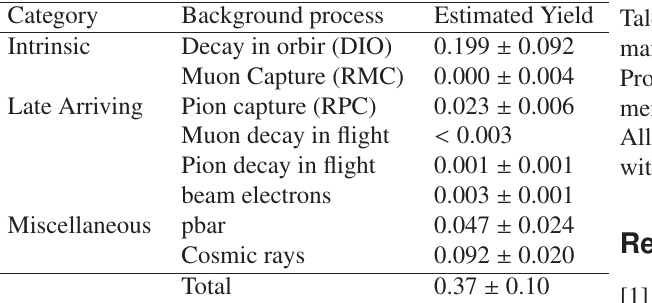
Table 1. Expected background list as evaluated by full simulation. Extracted from the Mu2e